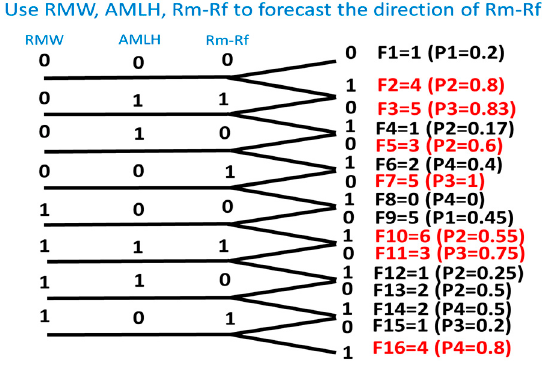
Figure A15. Use RMW, AMLH, and Rm-Rf to forecast the direction of Rm-Rf.